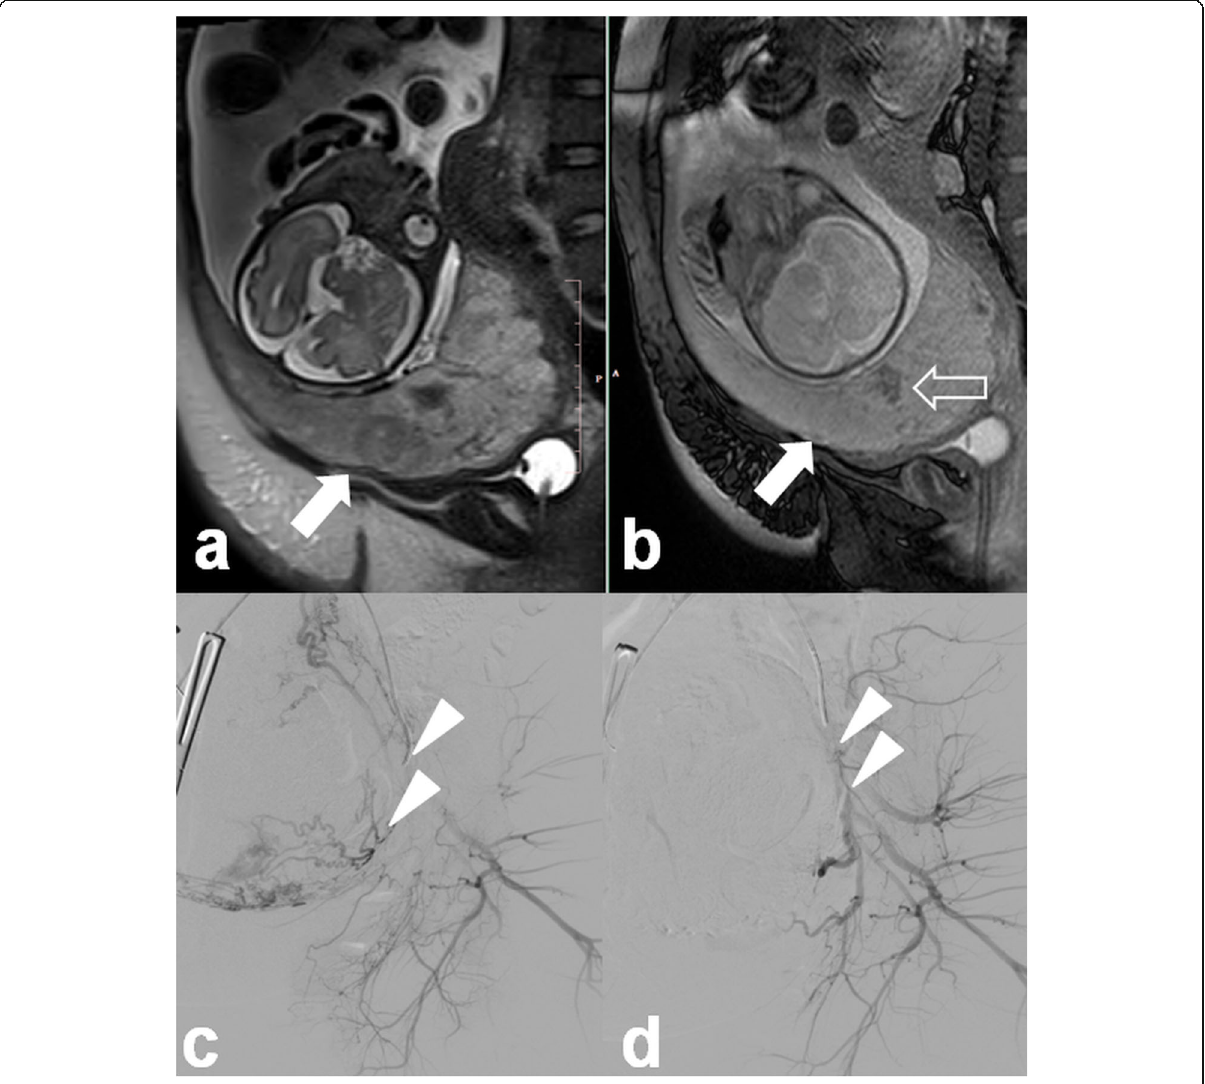
Fig. 2 A 26-year-old woman (gravida − 3) with history of previous Caesarean section. Sagittal T2 HASTE ( a ) and SSFP ( b ) MR images show placenta previa with loss of uteroplacental interface (arrows) and dark bands (open arrows). Since placenta accreta was present during elective Caesarean section, uterine artery embolization was performed. Digital subtraction images of left uterine artery pre-embolization ( c ) and post- embolization ( d )